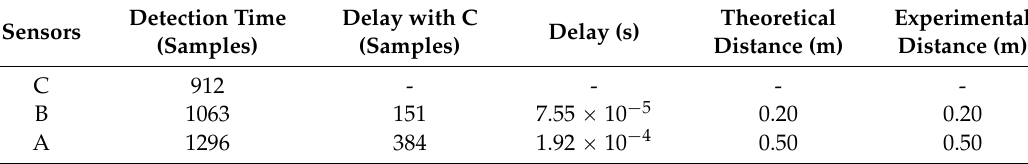
Table 3. Second case study: detection time; delay with C; delay; theoretical distance; experimental distance.